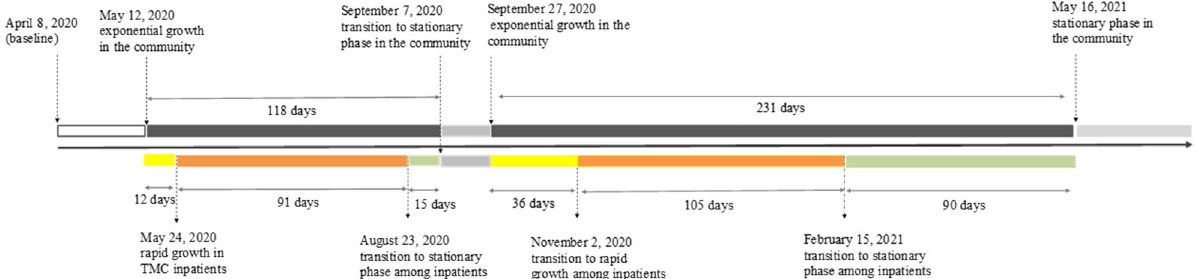
Figure 3. Transition periods to SARS-CoV-2 outbreak in Harris County community and among inpatients in Texas Medical Center. Critical phases of SARS-CoV-2 outbreak (i.e., exponential growth + deceleration stages) in Harris County community (top row) and among TMC inpatients (bottom row). Dark gray areas indicate exponential growth and deceleration stages. Yellow areas indicate lag periods between transition to exponential growth in the community and in local hospitals. Light green areas indicate lag periods between transition to stationary/linear growth in the community and in local hospitals.